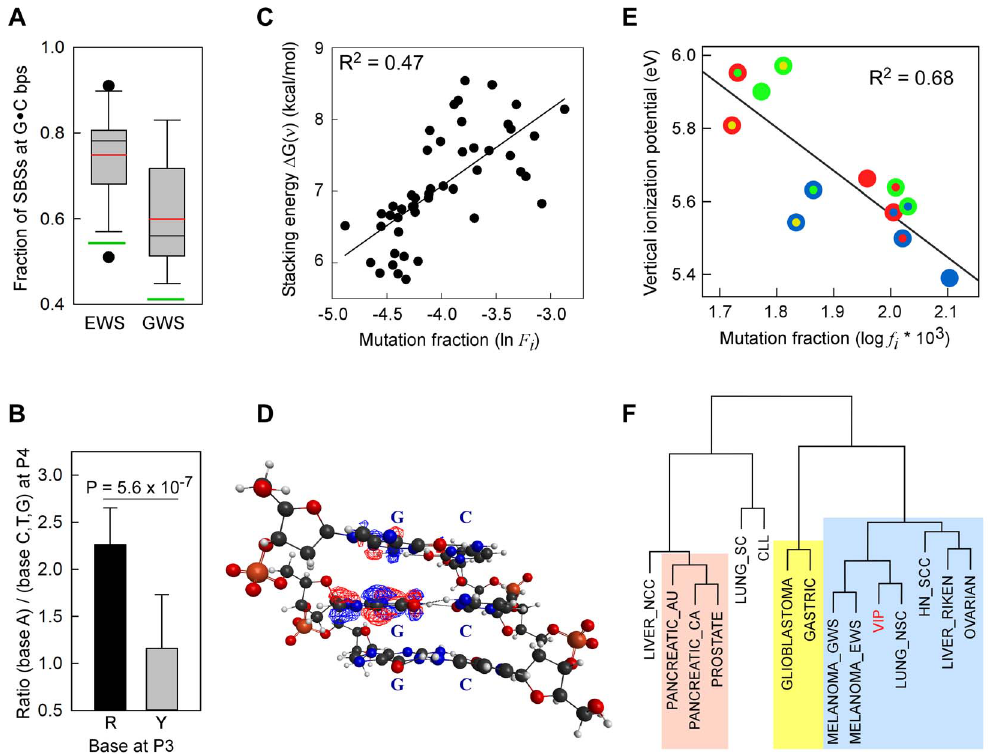
Figure 1. SBSs and VIPs. Panel A , whisker plot of the fractions of SBSs at G N C bp for the EWS and GWS datasets computed using AgilentV2 and Duke35 mappability counts, respectively; red line , mean; black line , median; green lines , average GC-contents in the mappable AgilentV2 (EWS) and Duke35 (GWS) sets. Panel B , NGRA sequences are enriched in SBSs in melanoma. y-axis , for each 4-member sequence combination with matching P1– P3 bases, the fraction of mutations at P4-A was divided by the average fraction of mutations at P4-(C/T/G); x-axis , P3 base composition; R , purine; Y , pyrimidine; mean 6 SD; P-value from two-tailed t -test. Panel C , the ln of normalized fractions of mutated DGNN (D=A/G/T) sequences, F i , for the seven cancer datasets with 2 logP $ 3 for DGRN . DGYN (Table 1) were combined and plotted as a function of the average absolute free energy of base stacking, D G( n ), for each of the 48 DGNN sequences. Panel D , three-dimensional model of the (5 9 -GGG-3 9 ) N (5 9 -CCC-3 9 ) trinucleotide showing the LUBMO (lowest unoccupied beta molecular orbital) of the ionized sequence. Panel E , plot of the normalized fractions ( log f i 6 10 3 ) of mutated DGN sequences (Duke35 counts) for the Lung_nsc cancer dataset vs. VIPs; outer circle , 5 9 D base; inner circle , 3 9 N base; blue , adenine; green , guanine; red , thymine; yellow , cytosine. Panel F , agglomerative hierarchical clustering of 14 cancer genome datasets obtained from linear correlations with ln VIP values, as obtained from T_hg19 counts; colored boxes , elements found to be clustered at the 90% confidence interval.